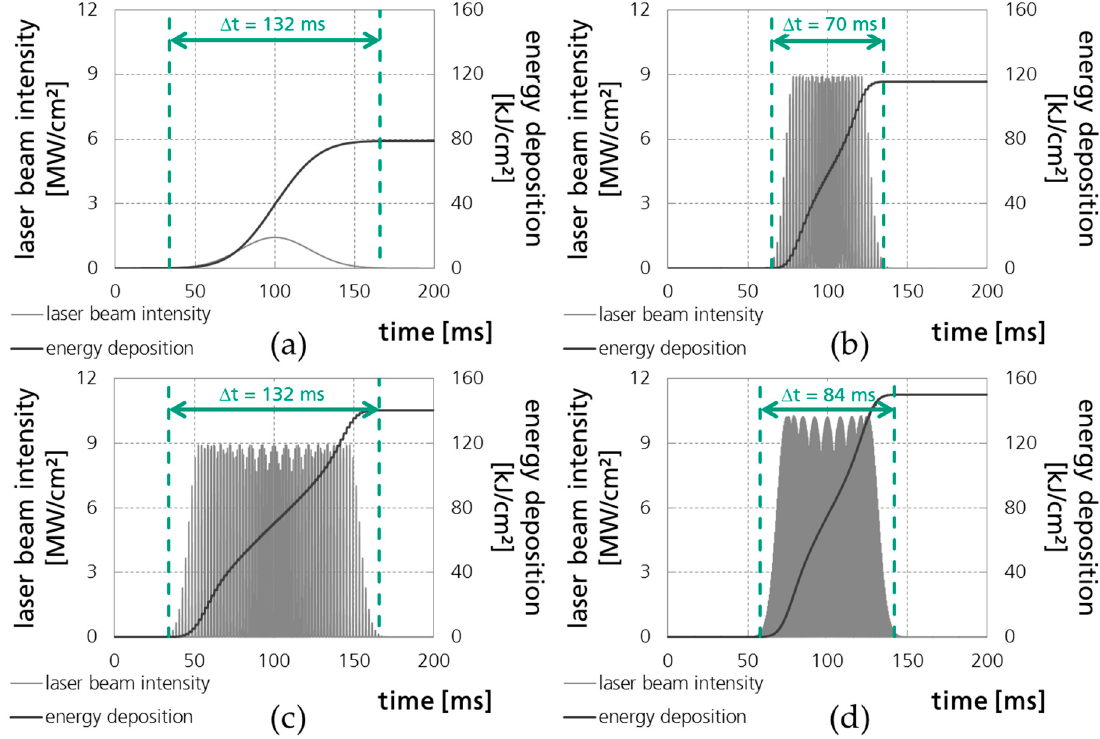
Figure 20. Comparison of the local intensity profile and energy deposition for one certain material position along the cut path as function of time for the following parameters: ( a ) Static beam shaping; and different values of the longitudinal, linear beam oscillation parameters: ( b ) 300 µ m amplitude and 500 Hz frequency; ( c ) 550 µ m amplitude and 500 Hz frequency; ( d ) 300 µm amplitude and 2000 Hz frequency; heat conduction as well as melt ejection have been disregard.